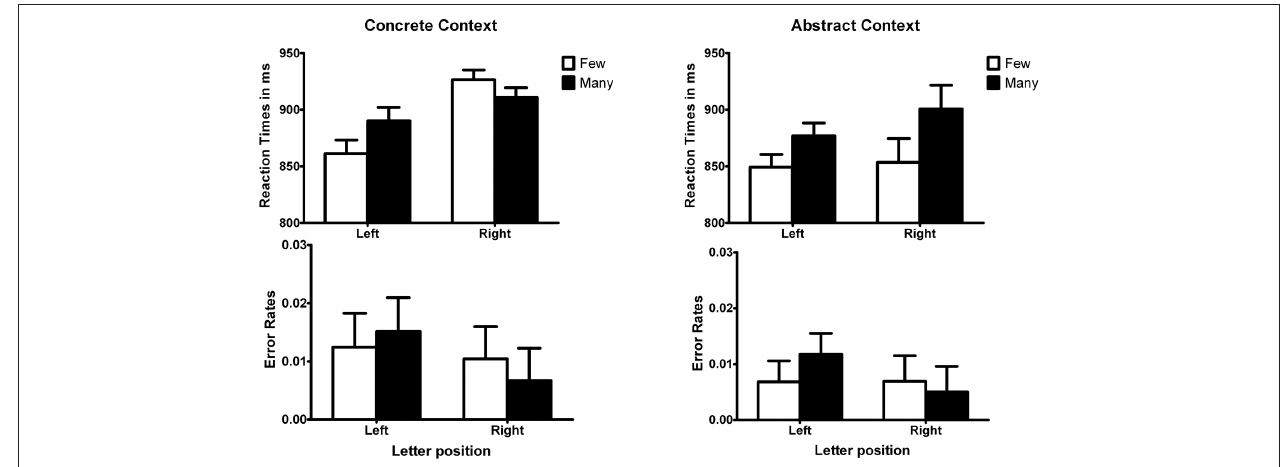
Figure 3 | reaction times and error rates for the letter identification task in experiment 4. Error bars represent standard error of the mean difference for adjacent